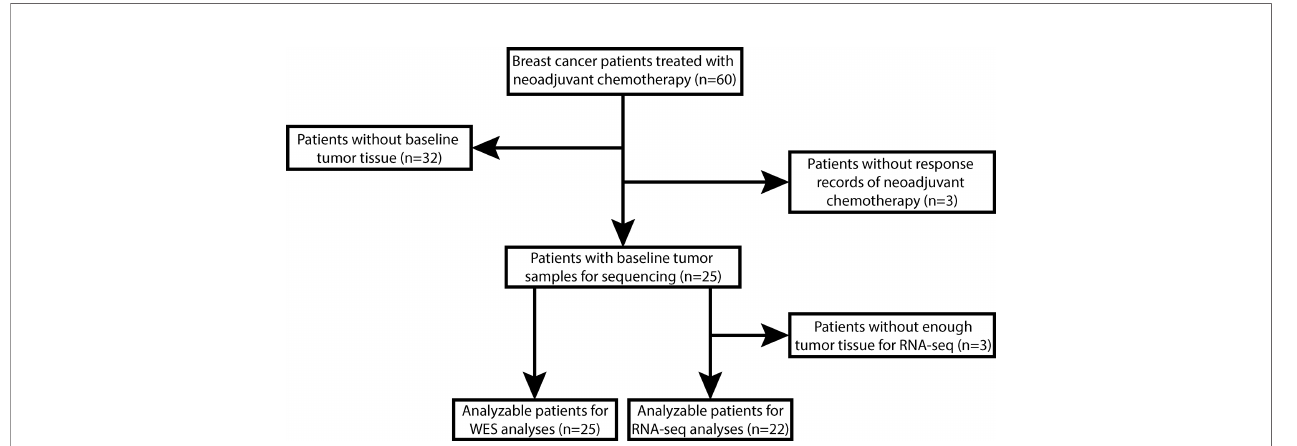
FIGURE 1 | The fl owchart of enrollment and analyzable patients. A total of 60 stage II/III breast cancer (BC) patients planned to receive breast-conserving surgery and neoadjuvant chemotherapy (NAC) of epirubicin, cyclophosphamide plus docetaxel with or without herceptin (EC-T(H)) were eligible for participation. We excluded 32 patients without available baseline tumor tissues and 3 patients without NAC response records, and the remaining 25 patients were enrolled in this study. All these 25 patients were analyzable for whole-exome sequencing (WES) data analyses, but 3 patients without enough tumor tissue for RNA sequencing (RNA-Seq) were excluded from RNA-Seq data